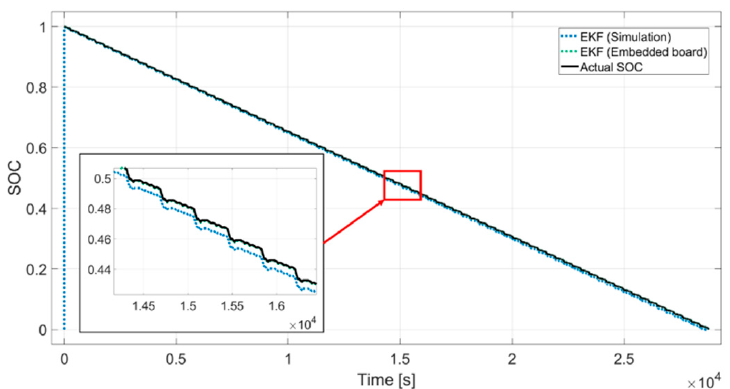
Figure 8. Scheme of communication protocol between Raspberry Pi.